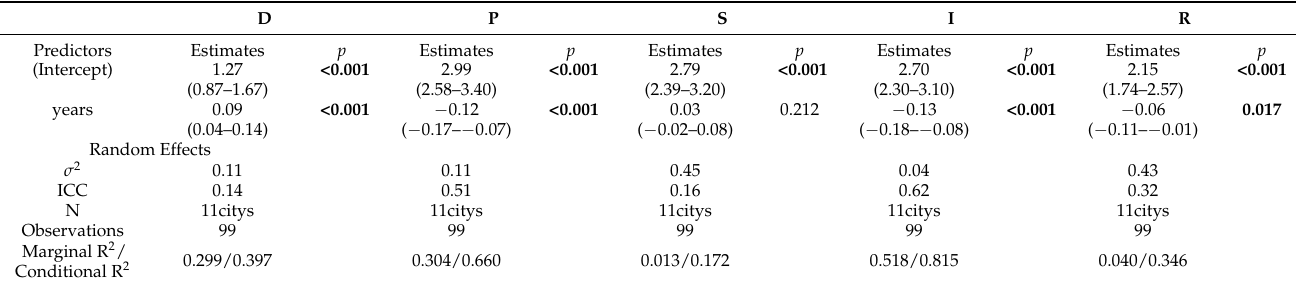
Table 4. LMM results of temporal trend analysis of the DPISR water resources